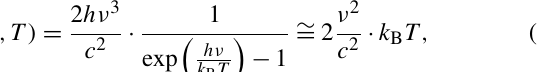
Figure 1. HALO MTP instrument. (a) Position of the MTP under- neath the wing of the HALO aircraft. (b) MTP sensor unit in the lab. Marked with numbers are the radiometer unit (1), the hot cali- bration target (2), the rotating mirror (3), and the electronic unit (4), which contains various temperature sensors such as the scanning unit temperature and the pod air temperature